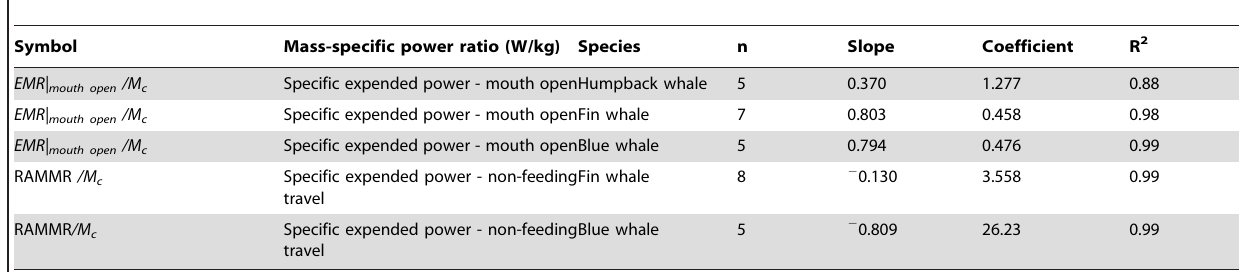
Table 7. Scaling of the metabolic power (EMR or RAMMR) expended during engulfment (mouth opening only) and non-feeding swimming, with respect to body length ( L body